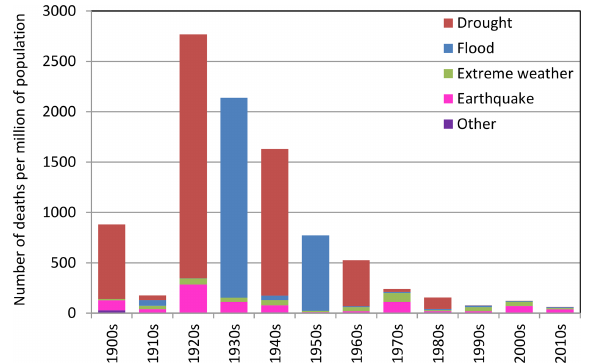
Figure B5. Evolution of the frequency of deaths from floods and droughts per decade in the 20th and 21st century. For compari- son, deaths from other categories of natural catastrophes are also plotted: “extreme weather” includes storms, extreme temperatures (cold- or heatwave, severe winter conditions) and fog; “earthquake” also includes tsunamis; “other” comprises landslides (wet or dry), rockfalls, volcanic activity (ash fall, lahar, pyroclastic flow and lava flow) and wildfires. For the sources of the data, see entry 23 in Ta- ble